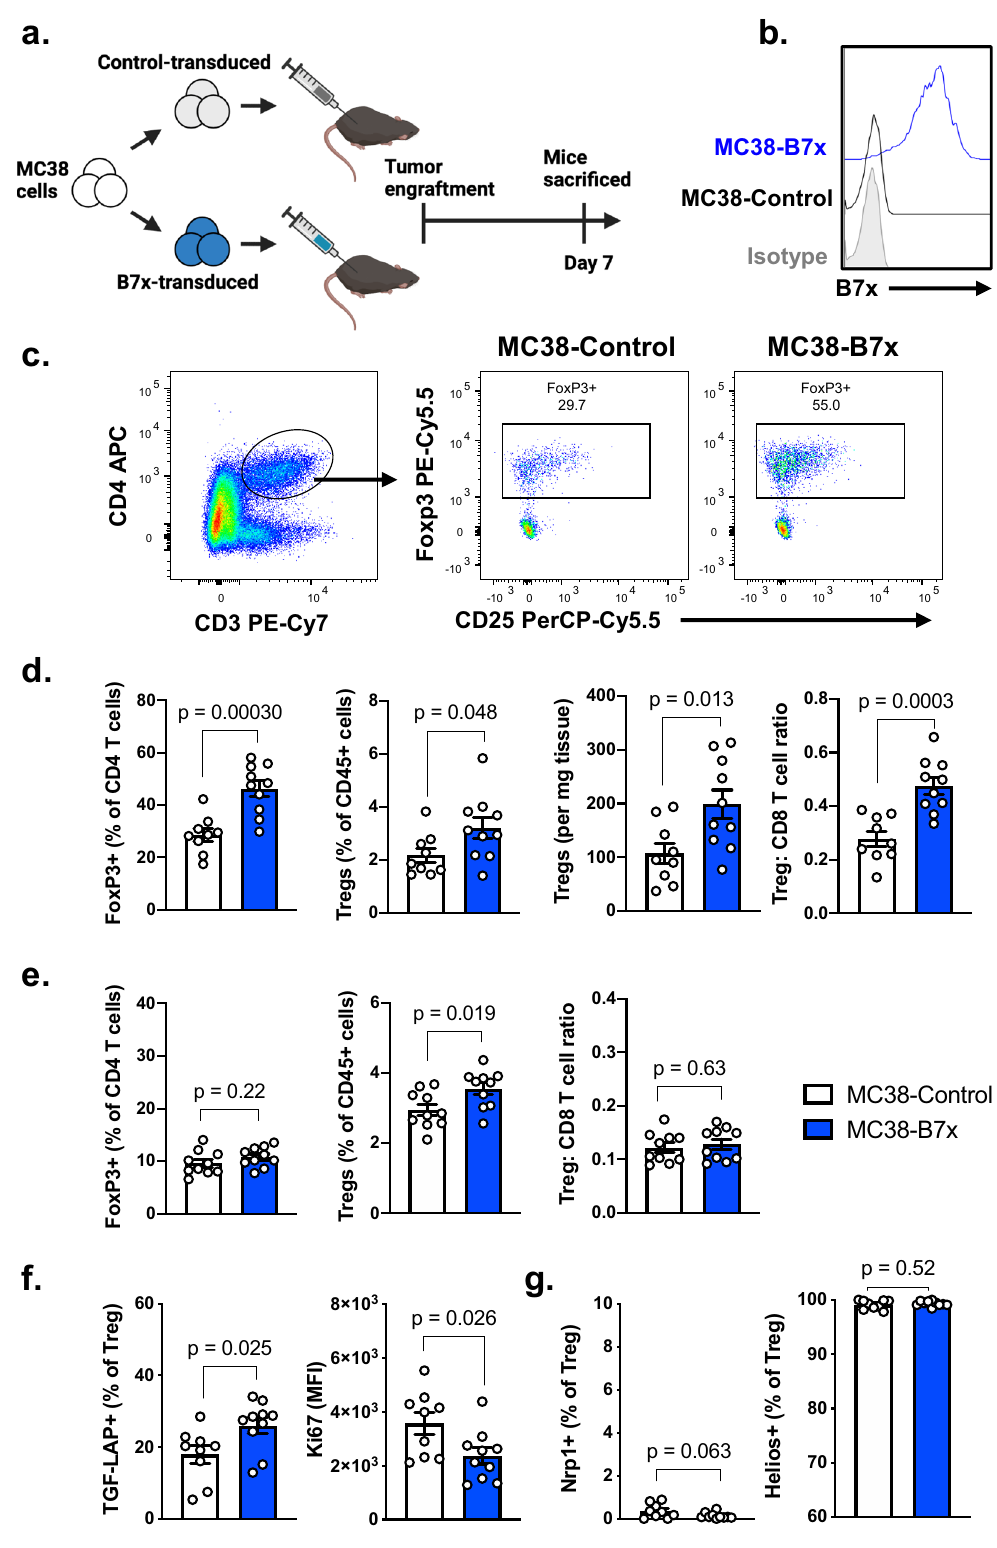
Fig. 1 Tumor-expressed B7x promotes in fi ltrating Treg populations. a Experimental scheme of MC38 tumor engraftment. b Representative fl ow cytometry analysis of B7x expression in MC38-B7x and MC38-Control cells. c Representative gating strategy for Tregs in CD45 + cells. d , e Populations of CD4 + T cells and CD8 + T cells were analyzed within dissociated tumors ( d ) and draining lymph nodes ( e ). f , g Gated on Tregs, surface TGF-LAP and intracellular Ki67 ( f ), and surface Nrp1 and intracellular Helios ( g ) was determined. n = 9 mice in control group and 10 mice in B7x group, representative of three independent experiments. For ( d – g ), error bars represent SEM and P values were calculated by two-tailed Student ’ s T -test, unadjusted for multiple